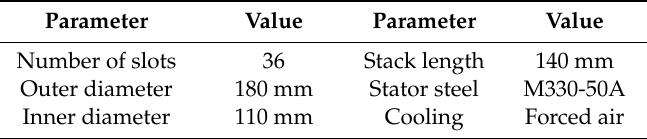
Figure 2. FMSynRM geometry. Table 1. Stator parameters of FMSynRM.